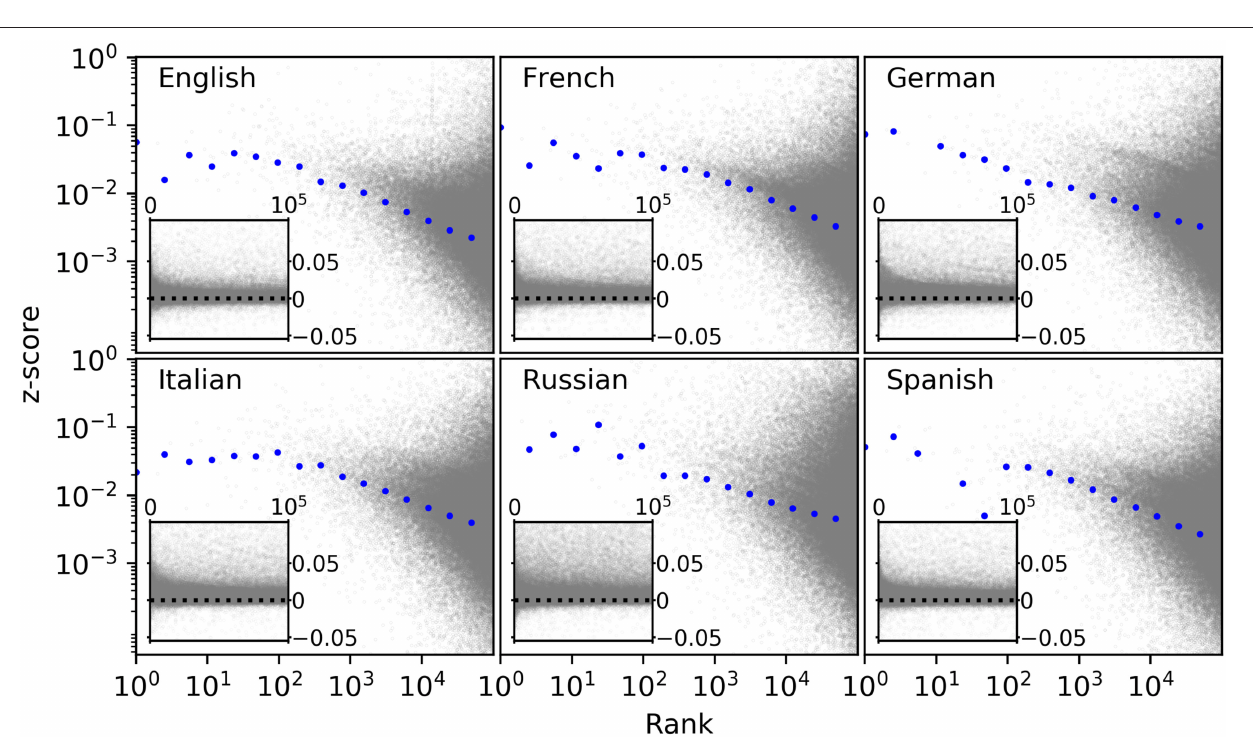
FIGURE 4 | Rank diversity in the null model. Rank diversity d ( k ) of both empirical and randomly generated 2-grams. The rank diversity of the null model tends to be to the right of that of the data, i.e., lower. Windowing in this and similar figures is done in the same way as in Figure 2 .